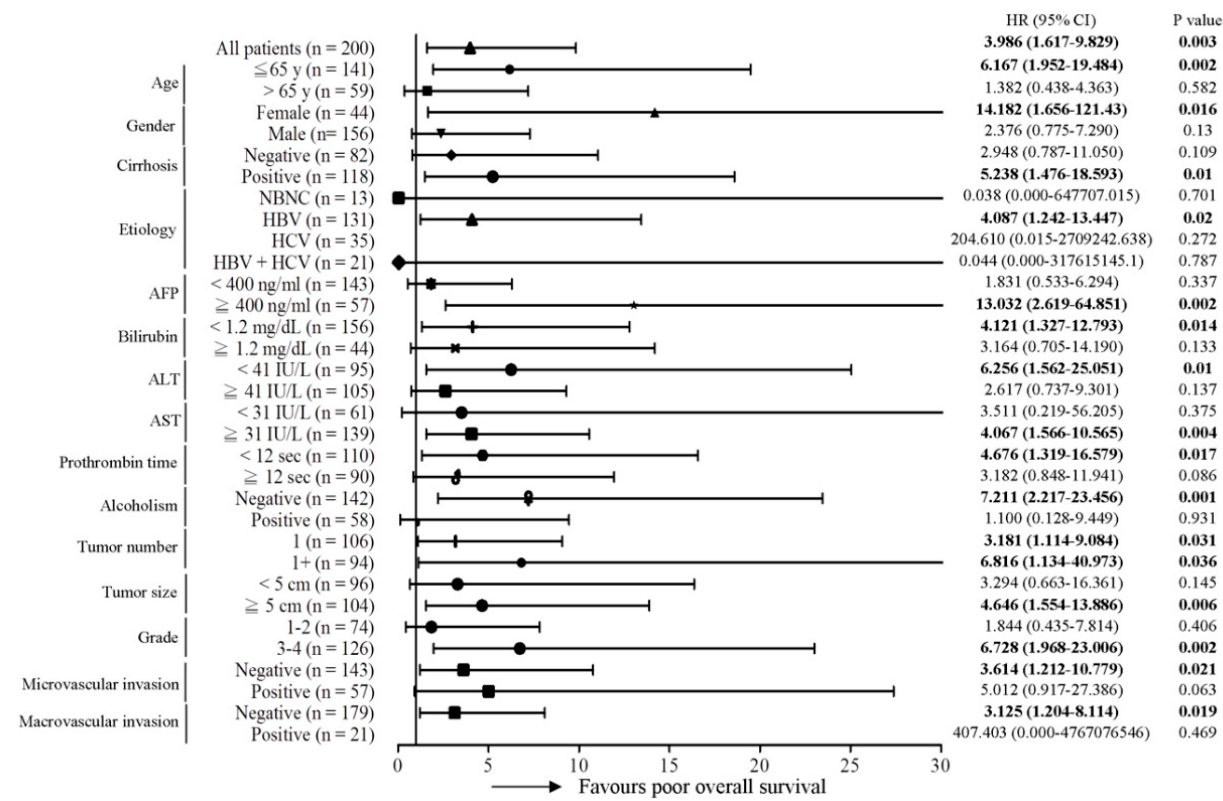
Figure 2. Forest plot subgroup analysis of HCC patients stratified by various clinical parameters to evaluate associations between MT-RNR1 G709A and overall survival. The Cox proportional hazard model was used to analyze MT-RNR1 G709A in relation to the overall survival in subgroups. Horizontal lines represent 95% confidence intervals. non-hepatitis B/non-hepatitis C (NBNC): patients without HBV or hepatitis C virus (HCV) infection. HBV: patients with HBV infection. HCV: patients with HCV infection. The cut-off values for AFP, ALT, and AST were 400 ng/mL, 41 IU/L, and 31 IU/L.